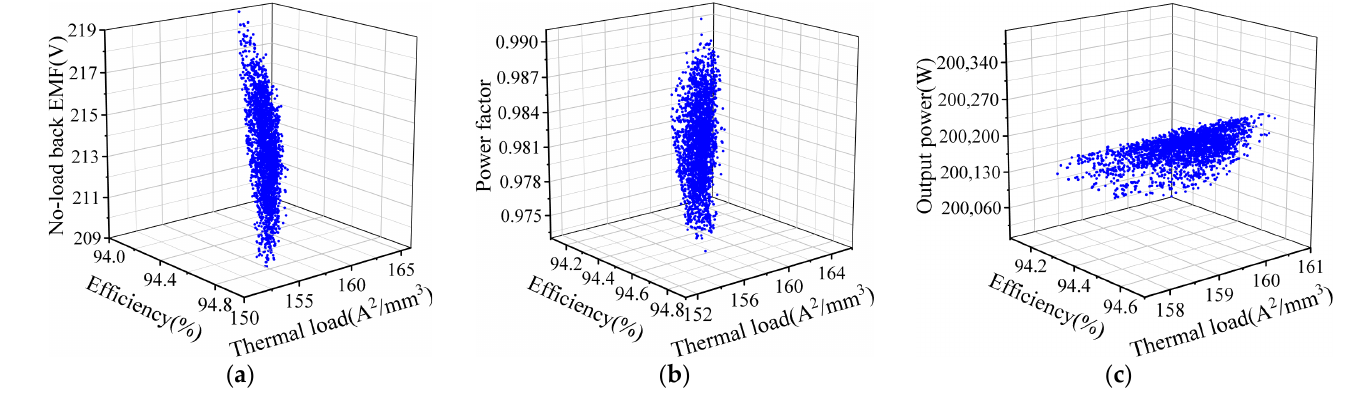
Figure 11. Relationship between multi ‐ objective performances. ( a ) Relationship between phase back EMF, efficiency and thermal load; ( b ) relationship between power factor, efficiency and thermal load; ( c ) relationship between output power, efficiency and thermal load.